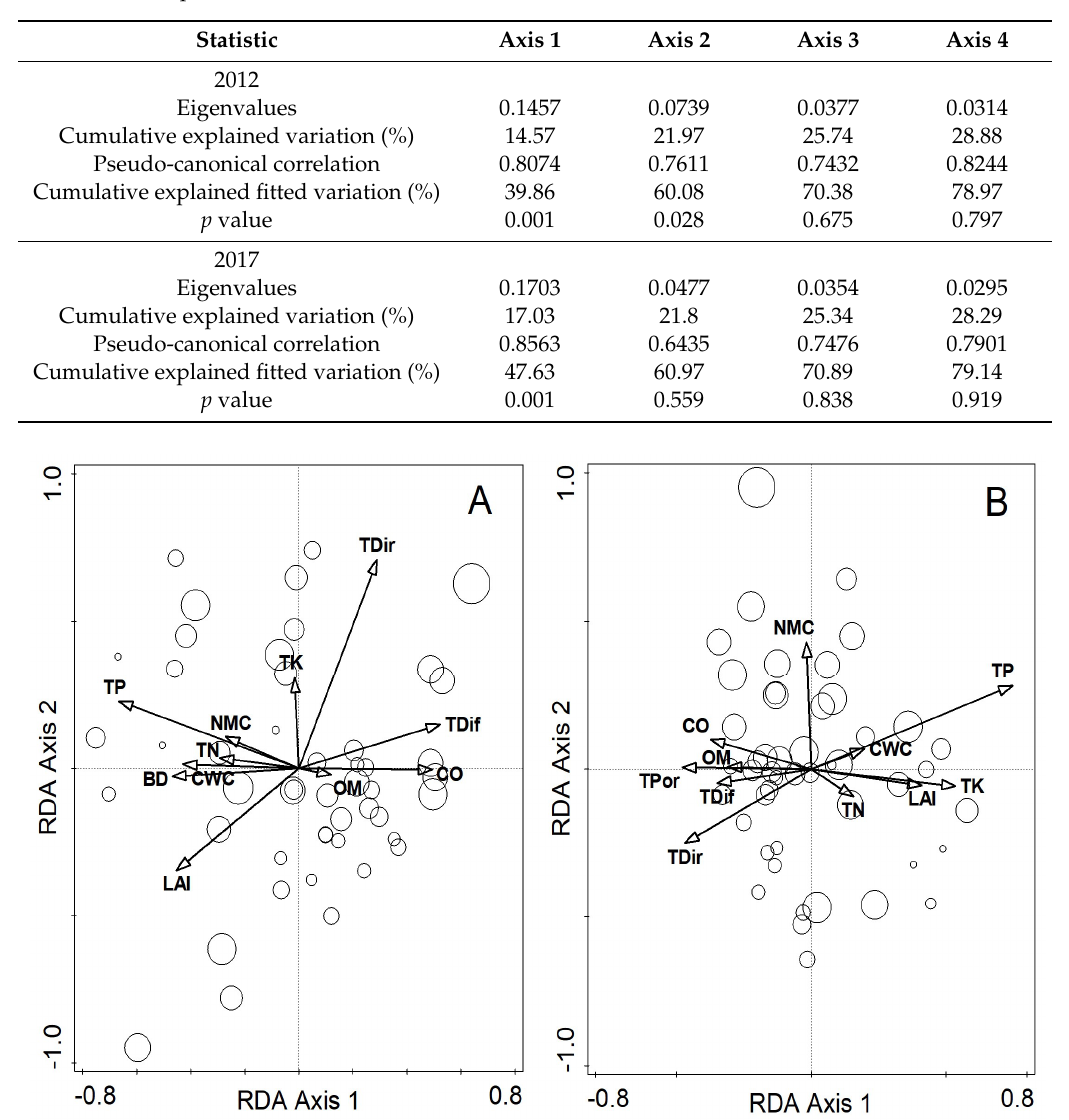
Table 6. Eigenvalues and explained variations of the first four axes in redundancy analysis (RDA) ordination of species distribution and environmental variables.